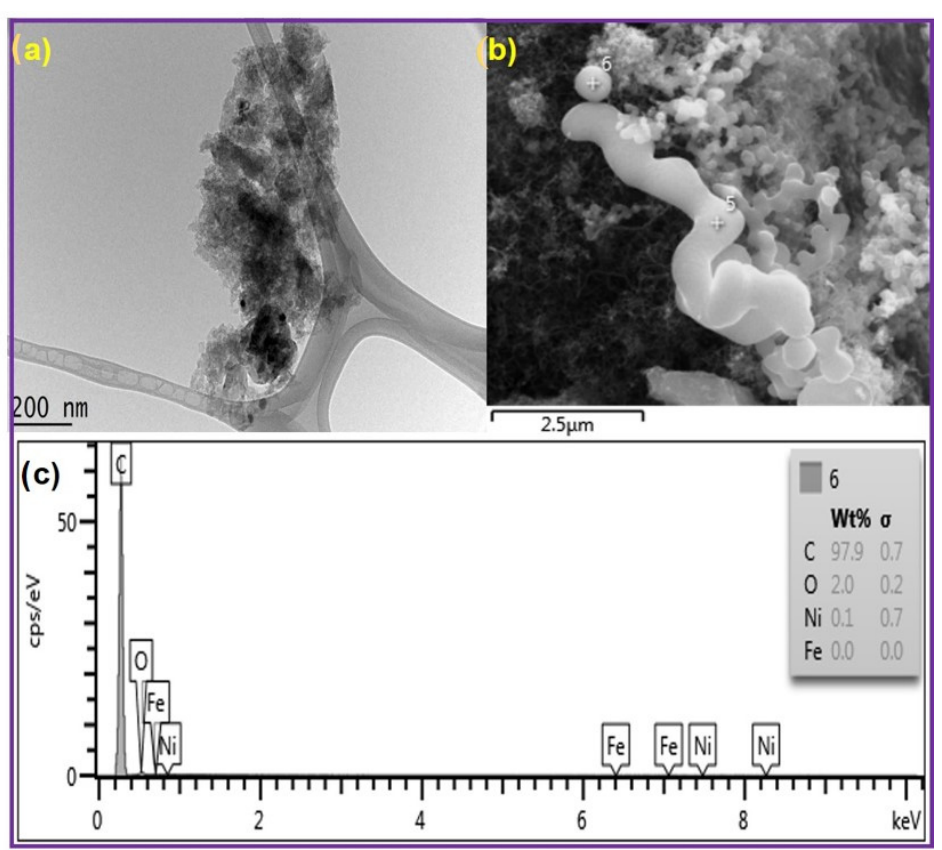
Figure 2. SEM and TEM images ( a , b ) for CNSs; ( c ) EDX analysis for PAC substrate .